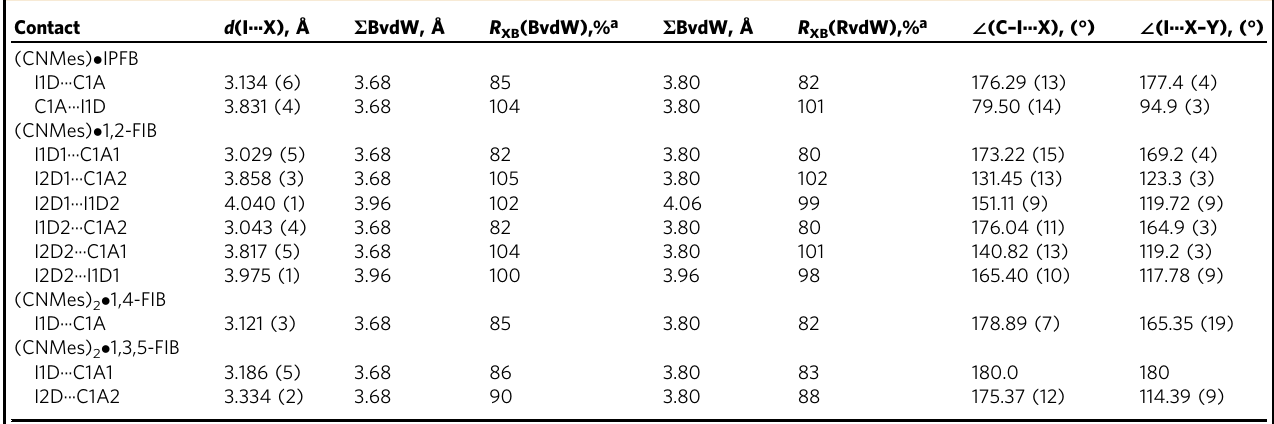
Table 1 Geometrical parameters for short contacts in the